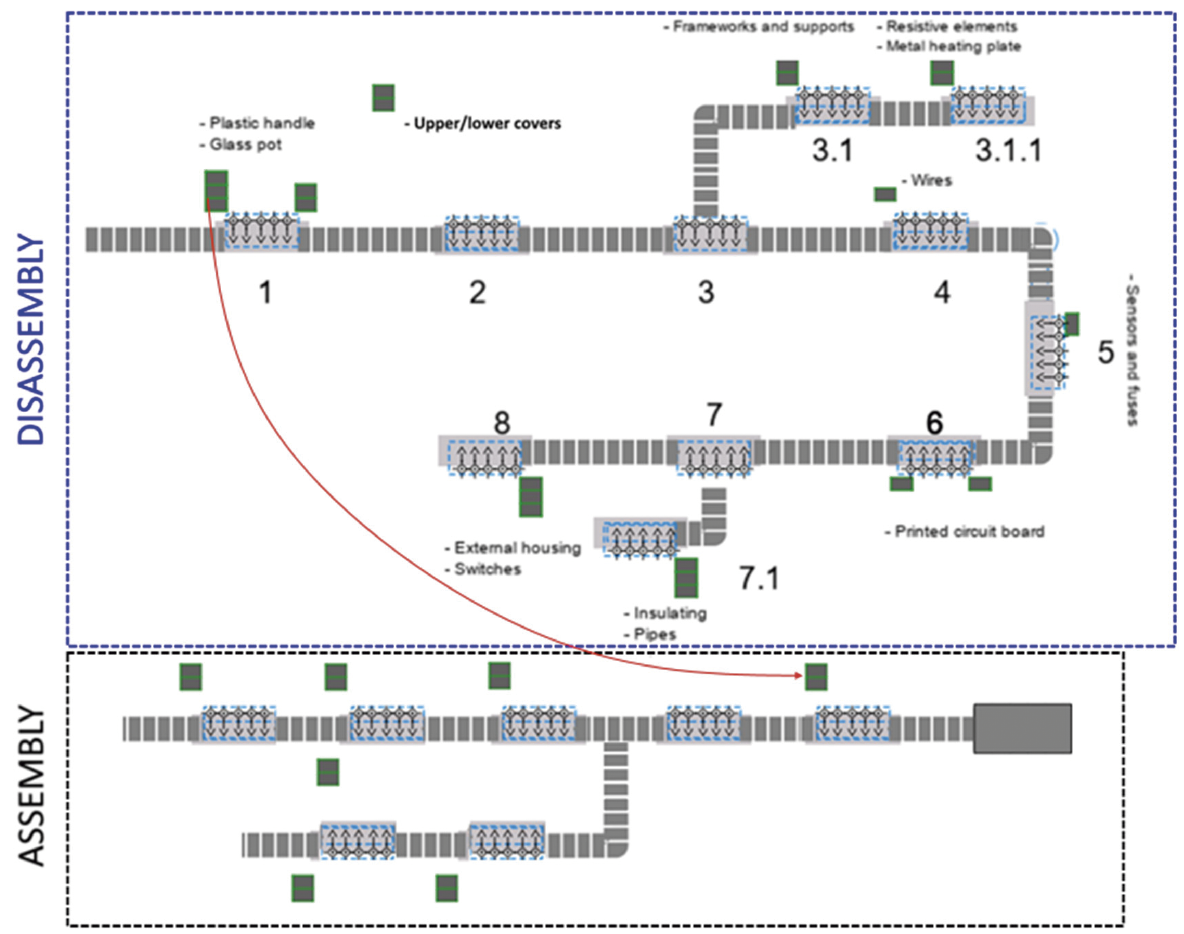
Figure 5. 2D view of the disassembly and assembly lines of the coffee maker in the virtual environment. The red arrow indicates the path of the components recovered by the first disassembly station that will be reassembled as new products